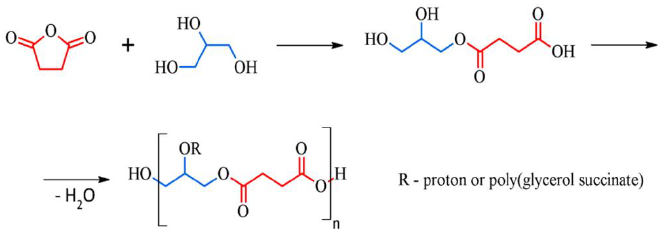
Figure 1. Reaction schematics of poly(glycerol) succinate (PGSu).